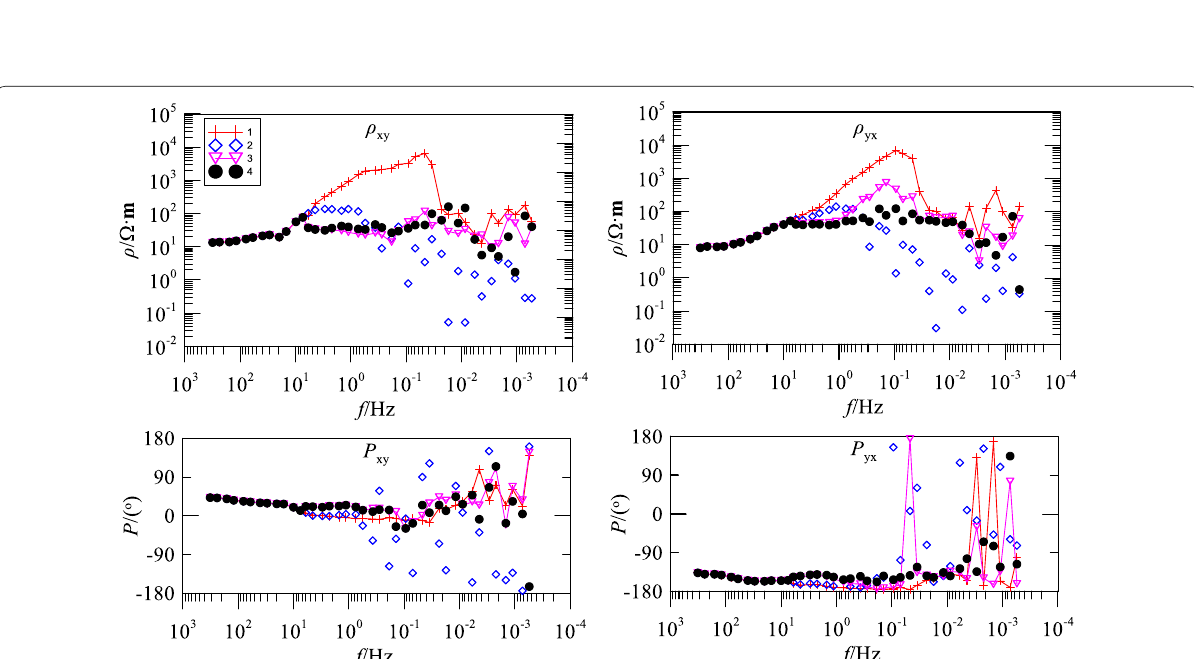
Fig. 6 Comparison of the apparent resistivity-phase curves of the measured MT site D37890; among them, curve 1 is the original data, curve 2 is the data filtered by the OMP-based overall method, curve 3 is the result derived from the fractal-entropy and clustering method, and curve 4 is the result derived from the proposed